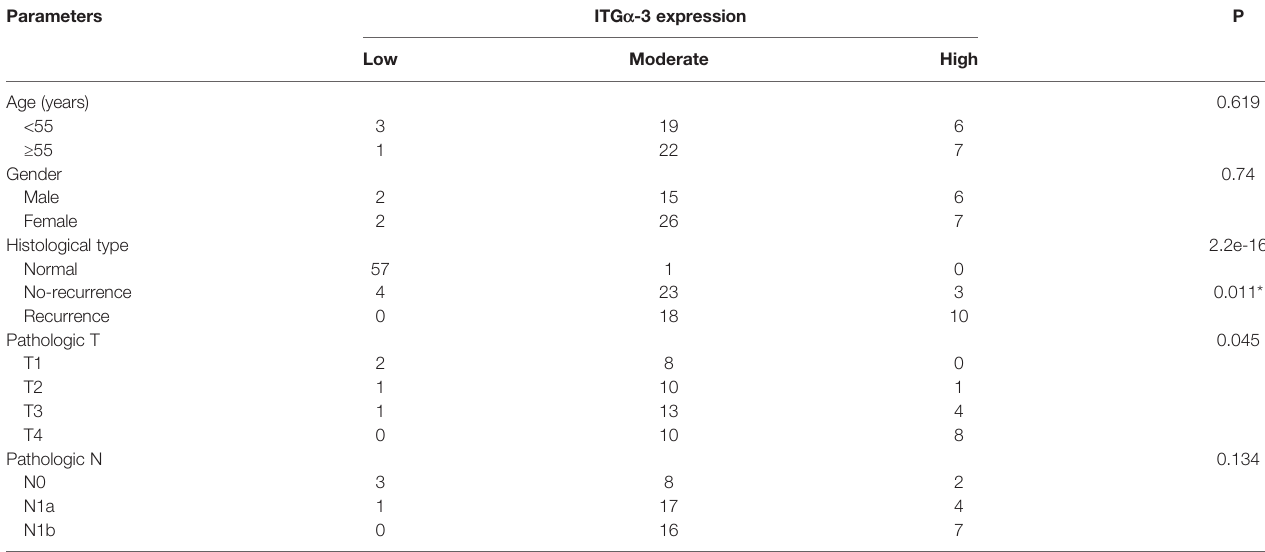
TABLE 5 | Correlation between the clinicopathologic characteristics and expression of ITGA3.